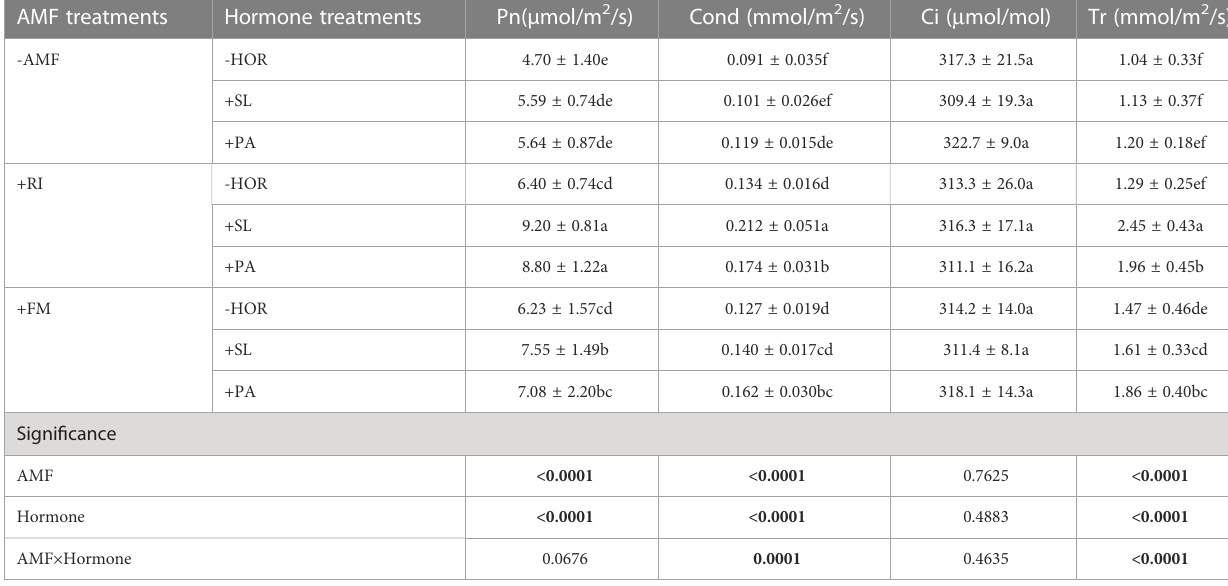
TABLE 4 Effects of AMFs and hormones on photosynthesis in tea cutting seedings. AMF